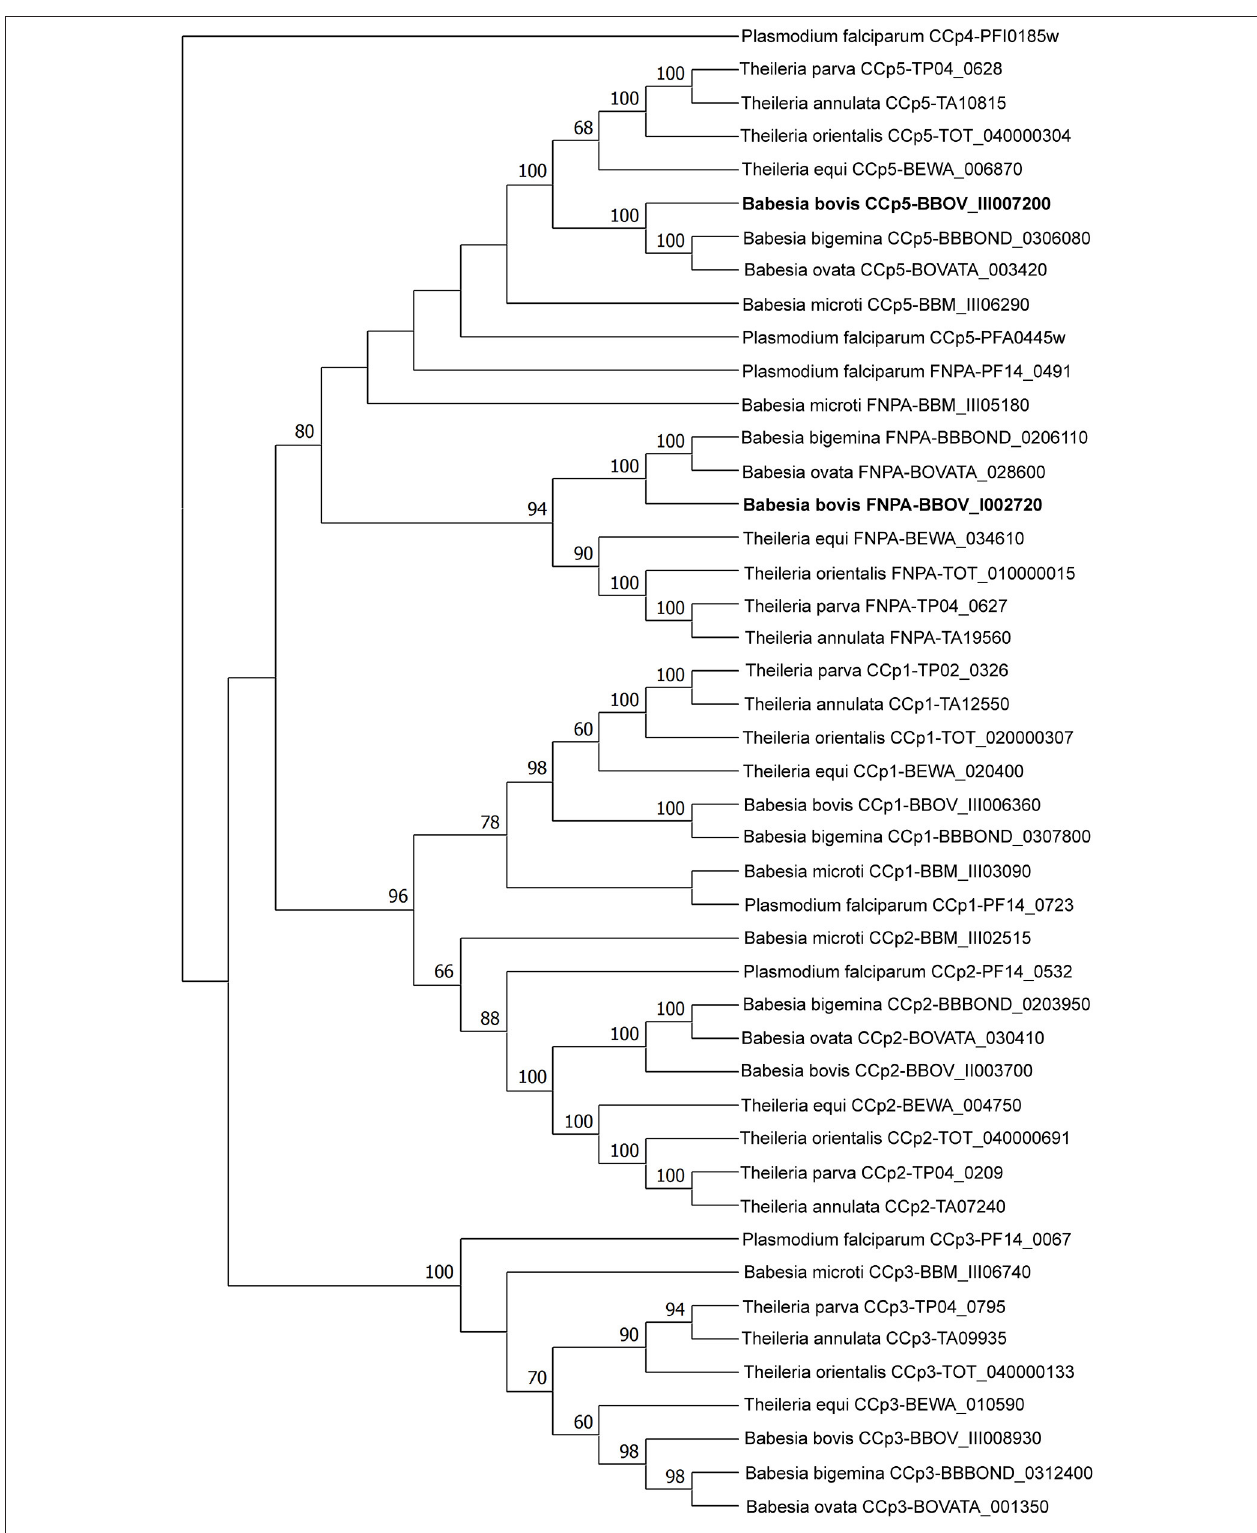
FIGURE 3 | Phylogenetic analyses of piroplasm CCp family protein sequences by maximum likelihood method based on the Whelan and Goldman + Freq. model (29). Sequences were obtained from the GenBank database. The newly identified B. bovis CCp5 and FNPA genes are shown in bold. The CCp4 gene sequence of P. falciparum was used as